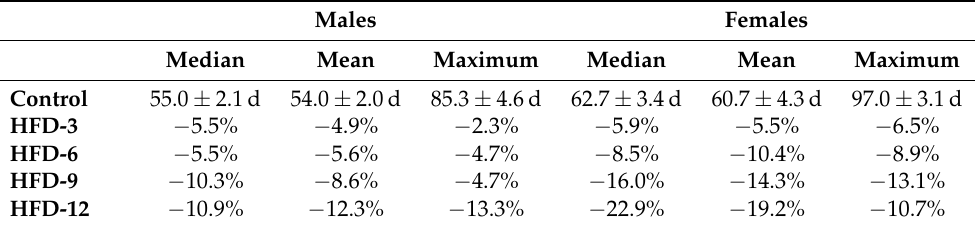
in addition 26% MUFAs and 3% PUFAs (Figure 5A,B). In contrast, SO and LO mainly exhibit PUFAs (SO: 55%, LO: 67%), MUFAs (SO: 34%, LO: 22%) and small proportions of SFAs (11%) (Figure 5A). In particular, SO mainly comprises fatty acids linoleic acid and oleic acid (Figure 5C), whereas LO primarily consists of linolenic acid and to a smaller proportion of oleic and linoleic acid (Figure 5E). OO exhibits predominantly MUFAs (80%) with oleic acid as main component, while amounts of SFAs (13%) and PUFAs (7%) are relatively small (Figure 5A,D). FO in comparison consists of 45% PUFAs and approximately the same proportions of SFAs (31%) and MUFAs (24%). The three major fatty acids of FO are palmitic acid, eicosapentaenoic acid (EPA) and docosahexaenoic acid (DHA) (Figure